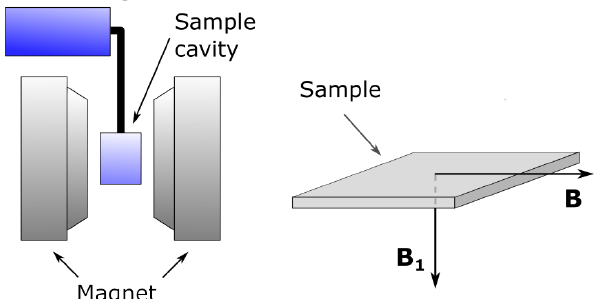
Figure 1. Schematic of the EMR setup, used for detection of LFMA signal and configuration of the sample with respect to the magnetic field vectors. B and B 1 denote the external magnetic field and microwave magnetic field,